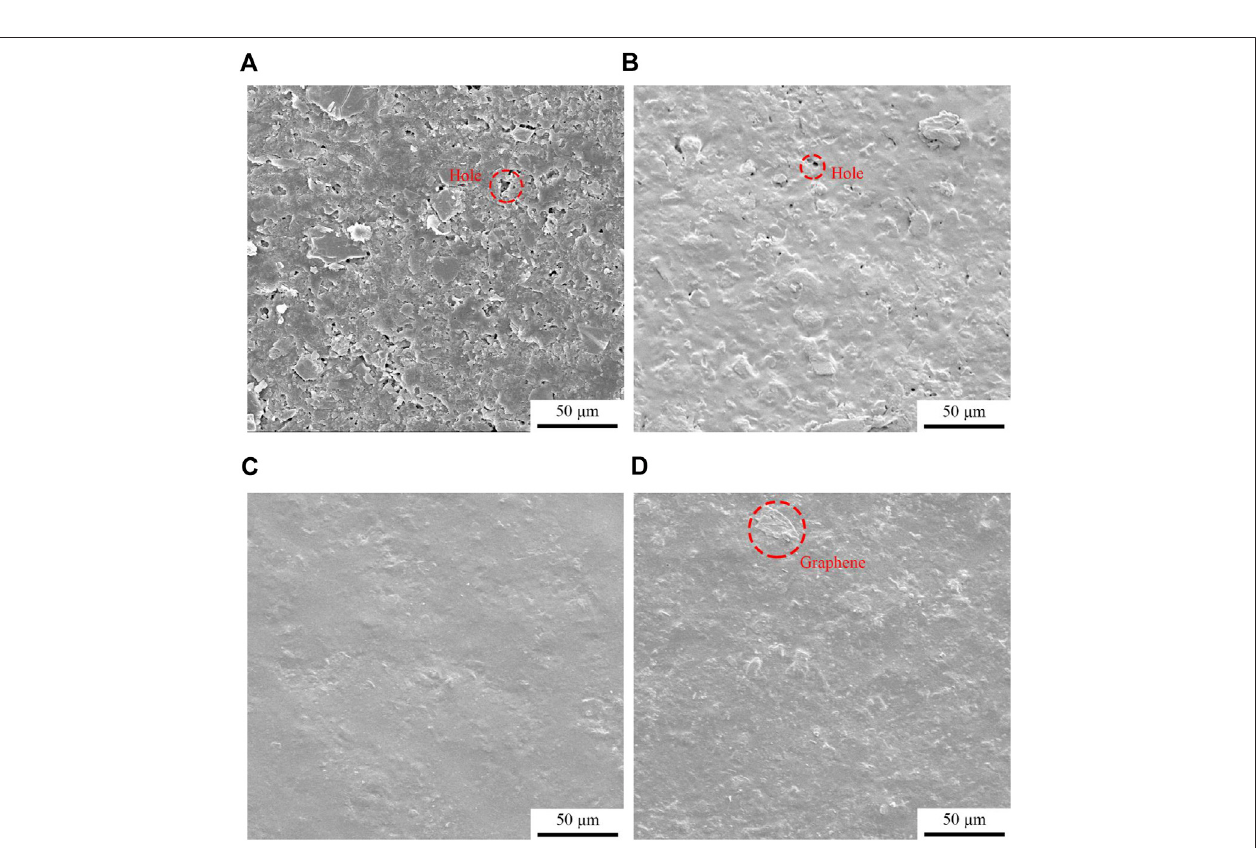
FIGURE 4 | Micro morphology of graphene modi fi ed oily epoxy resin coating: (A) G/OEP-0 wt%, (B) G/OEP-0.1 wt%, (C) G/OEP-0.3 wt%, (D) G/OEP-0.6 wt%.